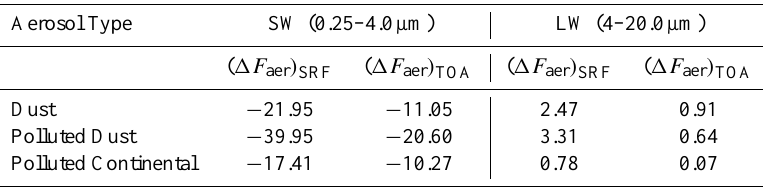
Table 3. Daytime average aerosol radiative forcing [Wm − 2 ] in short wavelength (SW) and long wavelength (LW) region for different absorbing aerosols during summer 2010 over the eastern Mediterranean basin.